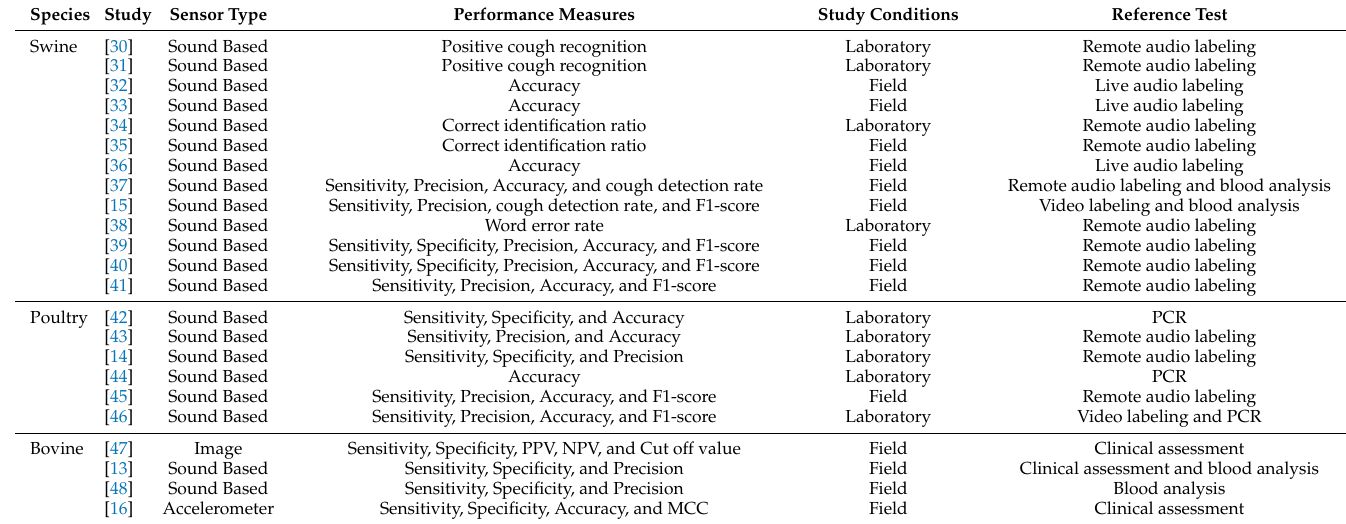
Table 2. Information about sensor type, performance measures, study conditions, and reference test of included articles for swine, poultry, and bovine